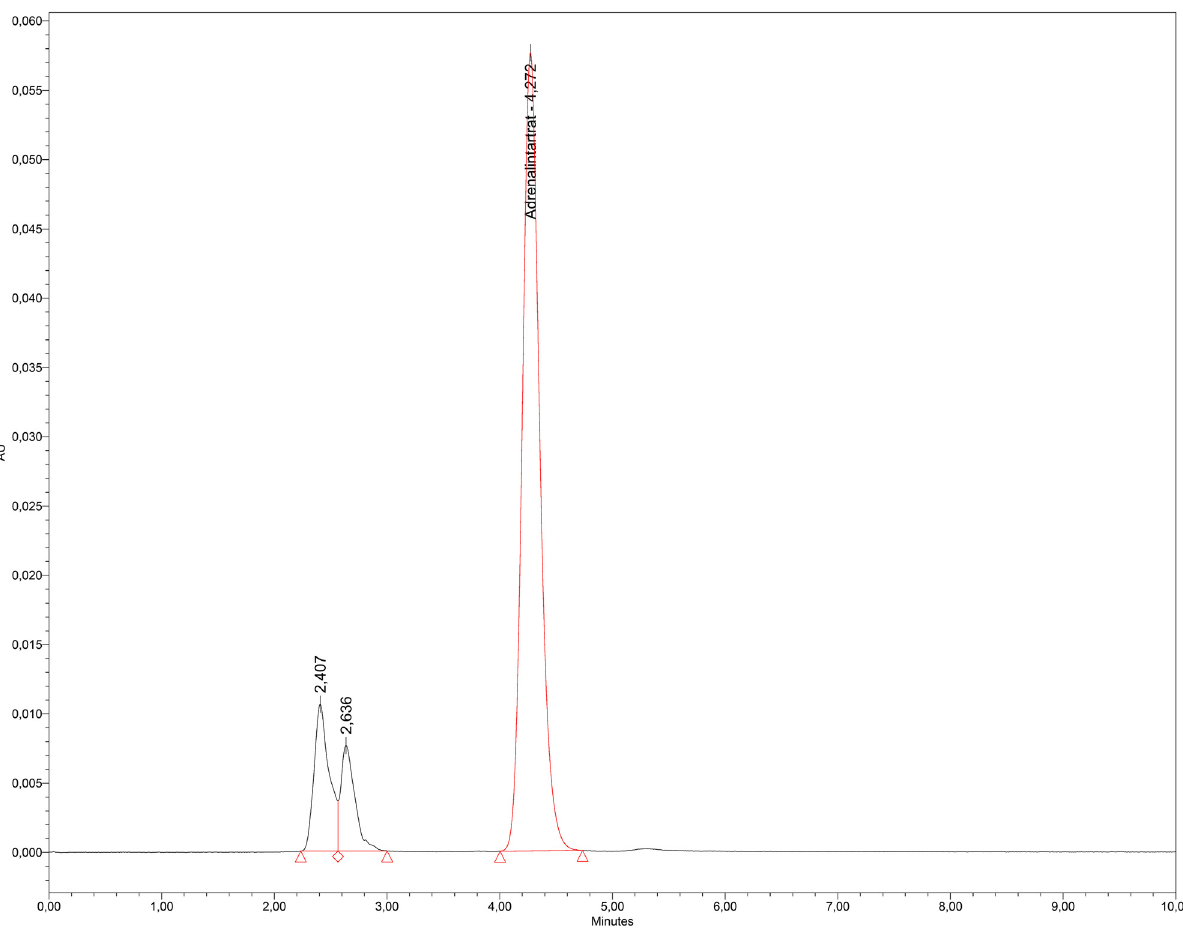
Figure 2: HPLC chromatogram of E 0.02 mg/mL, 50 mL injection solution, PDA at 230 nm (2.3 and 2.6 min: sodium-EDTA, 2.6. min: sodium metabisul fi